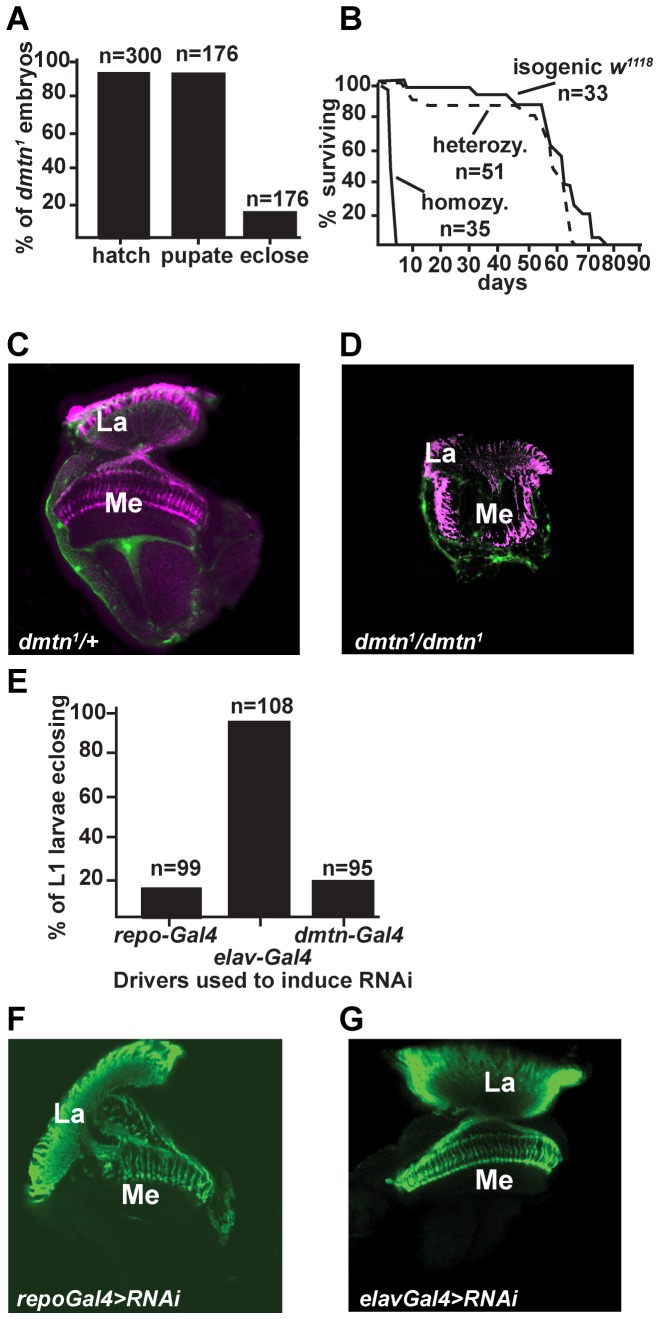
The effect of Dementin on survival and optic lobe development.(A) dmtn1 is a pupal lethal allele. Bars represent the percentage of dmtn1 flies that remain alive at various stages of development. (B) The survival rate of adult dmtn1 flies and controls; all flies were 9 generations or more isogenic. (C and D) dmtn1 flies have an underdeveloped medulla. Retinal axons projections into the optic lobe of heterozygous (C) and homozygous (D, n>26) dmtn1 flies expressing GFPnls under control of repo-Gal4 (green) were stained with mAb24b10 against Chaoptin (magenta). (E) RNAi for Dementin driven in glia with repo-Gal4 and with dmtn-Gal4, but not in neurons with elav-Gal4 is developmentally lethal. For a Western blot of extracts prepared from the heads of these flies see Figure 2B. (F and G) Optic lobes stained with antibody mAb24b10 for retinal axons show that RNAi for Dementin driven in glia with repo-Gal4 (F, n = 8), but not in neurons with elav-Gal4 (G, n = 12), recapitulates the medulla defects seen in dmtn1 flies. La, lamina; Me, medulla.